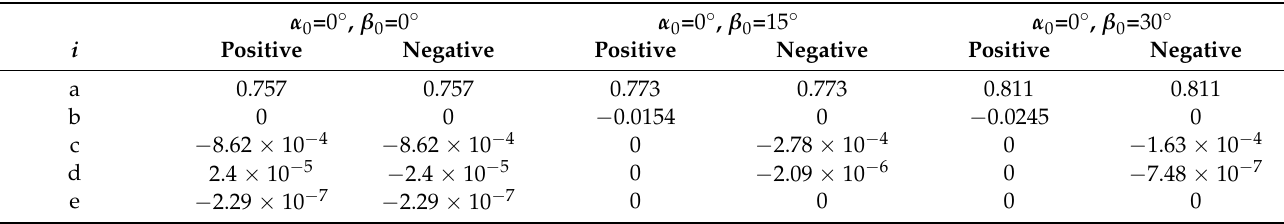
Table A1. Fitting parameters for the discharge coefficients of different Euler